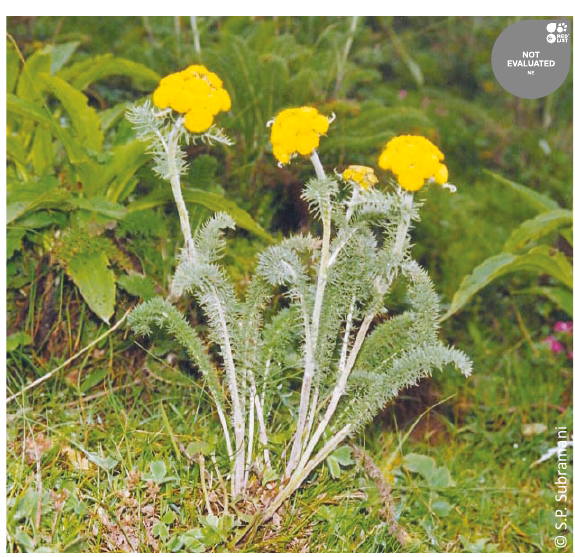
Image 10. Tanacetum longifolium Wall. ex DC.